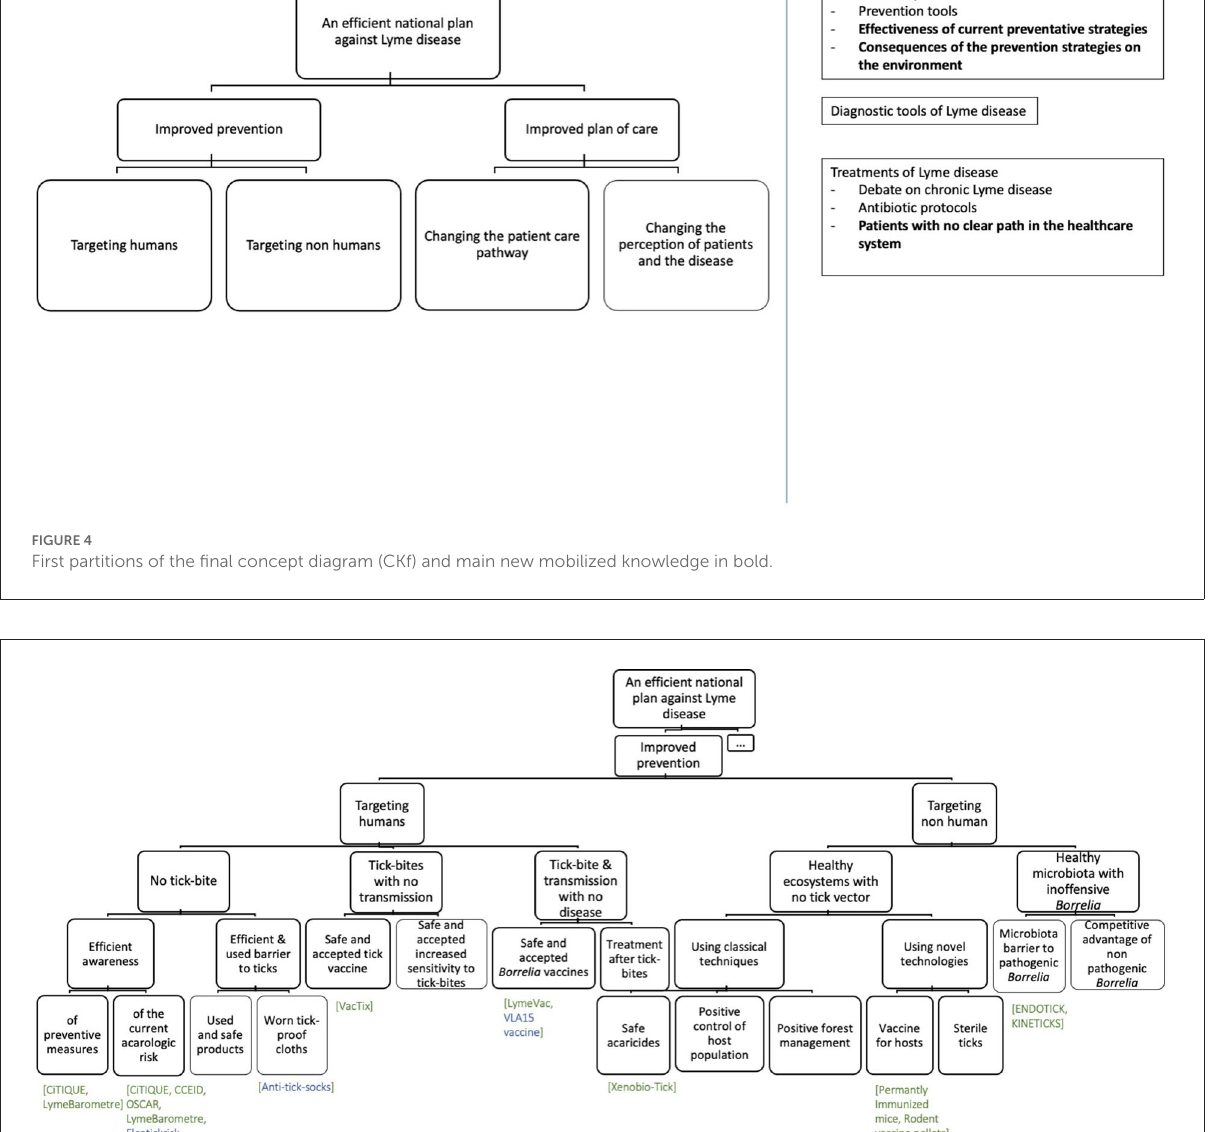
mosquitoes. The long-term effects of tools acting on other than humans may be politically unacceptable (e.g., culling of deer, deforestation) or very creative and perhaps important to the progress of technology (e.g., permanently immunized mice, GMO ticks), but they are considered impractical due